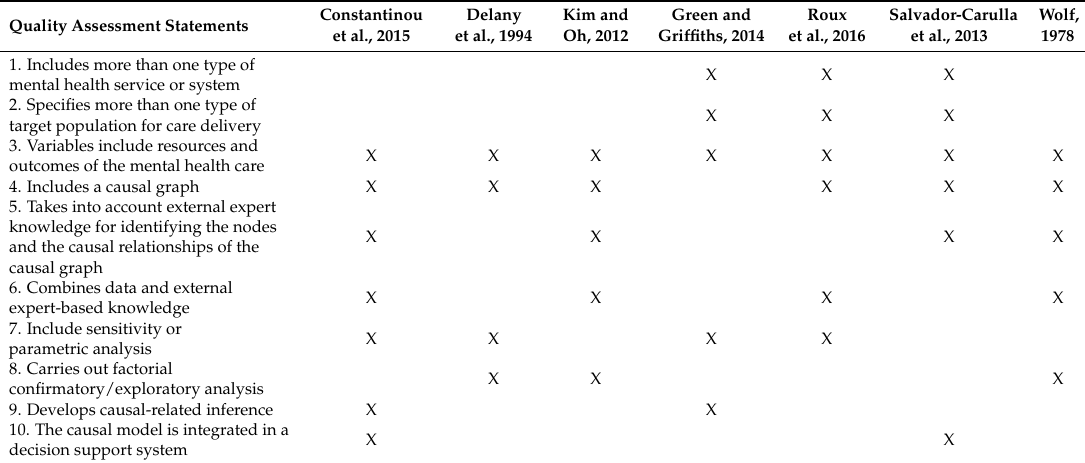
Table 6. Checklist for quality